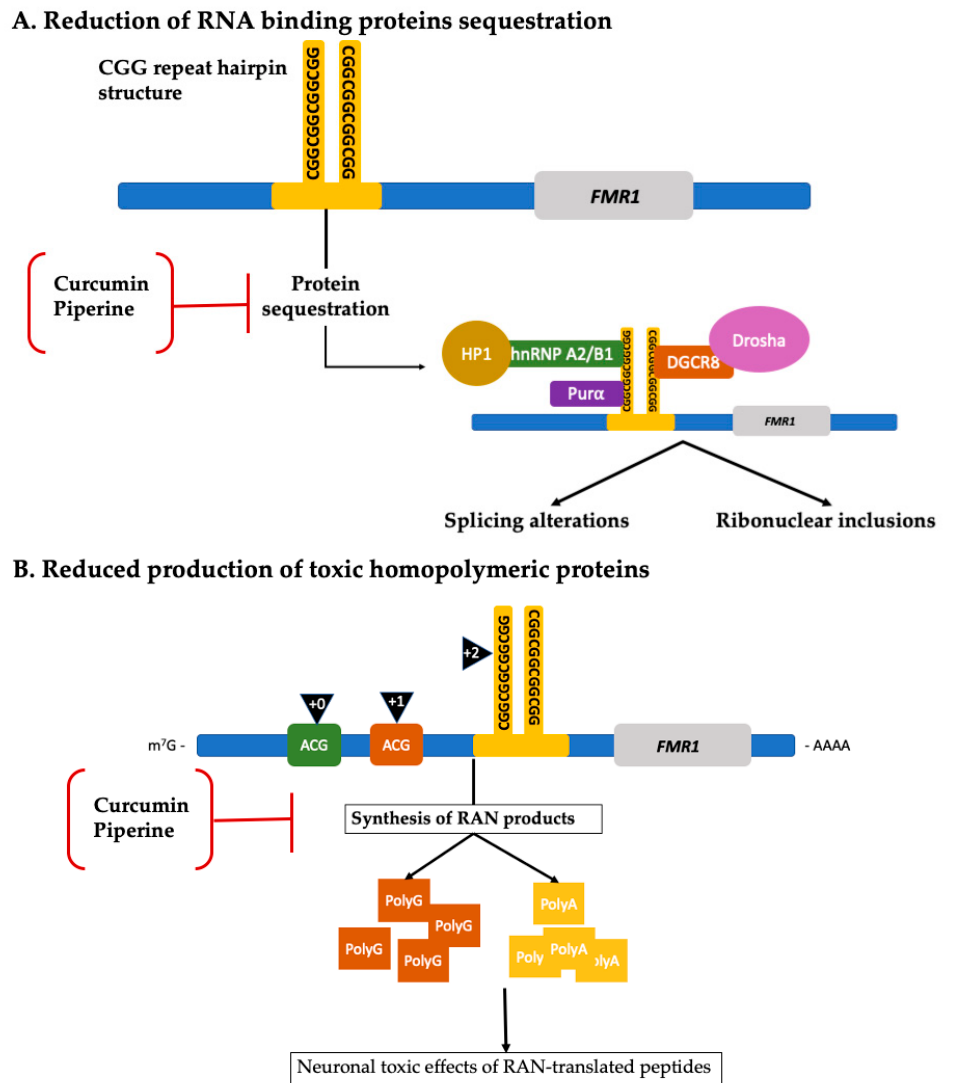
Figure 5. New therapeutic approaches and associated molecular pathways. ( A ) Compounds such as curcumin and piperine have shown to selectively bind the CGG repeat hairpin structure, inhibiting sequestration of RNA and other proteins that are normally involved in cellular mechanisms such as splicing, microRNA processing, and RNA transportation. By inhibiting the sequestration of such proteins, the cell is no longer functionally deficient from them, improving splicing alterations and reducing ribonuclear inclusions formation. ( B ) Curcumin and piperine can also decrease the synthesis of toxic homopolymeric proteins such as FMRpolyG (brown squares) and FMRpolyA (yellow squares), therefore reducing neuronal toxic effects caused by them [167,168]. (Adapted from Hagerman and Hagerman 2016; Glineburg et al. 2018) [12,127].